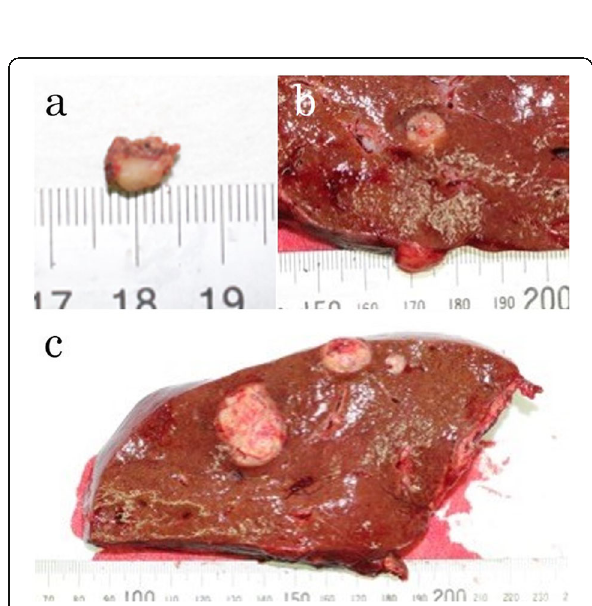
Fig. 3 Multiple tumors of the resected specimen. a The tumor in segment 4 of the liver was a 5-mm well-defined yellowish-white elastic lesion. b The tumor in segment 6 of the liver was a 7-mm well-defined yellowish-white elastic lesion. c The tumor in segment 5 of the liver was a 25-mm well-defined yellowish-white elastic